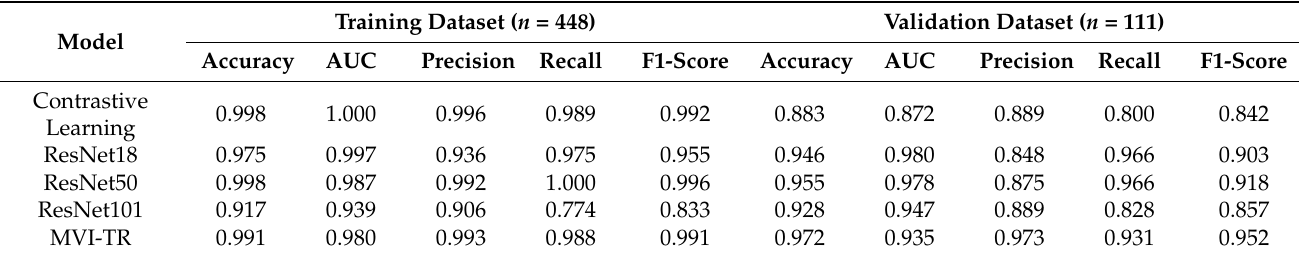
Table 2. The predictive performance of the proposed models.